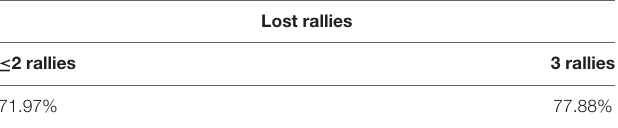
TABLE 5 | Probability of a positive timeout effect in unbalanced sets.